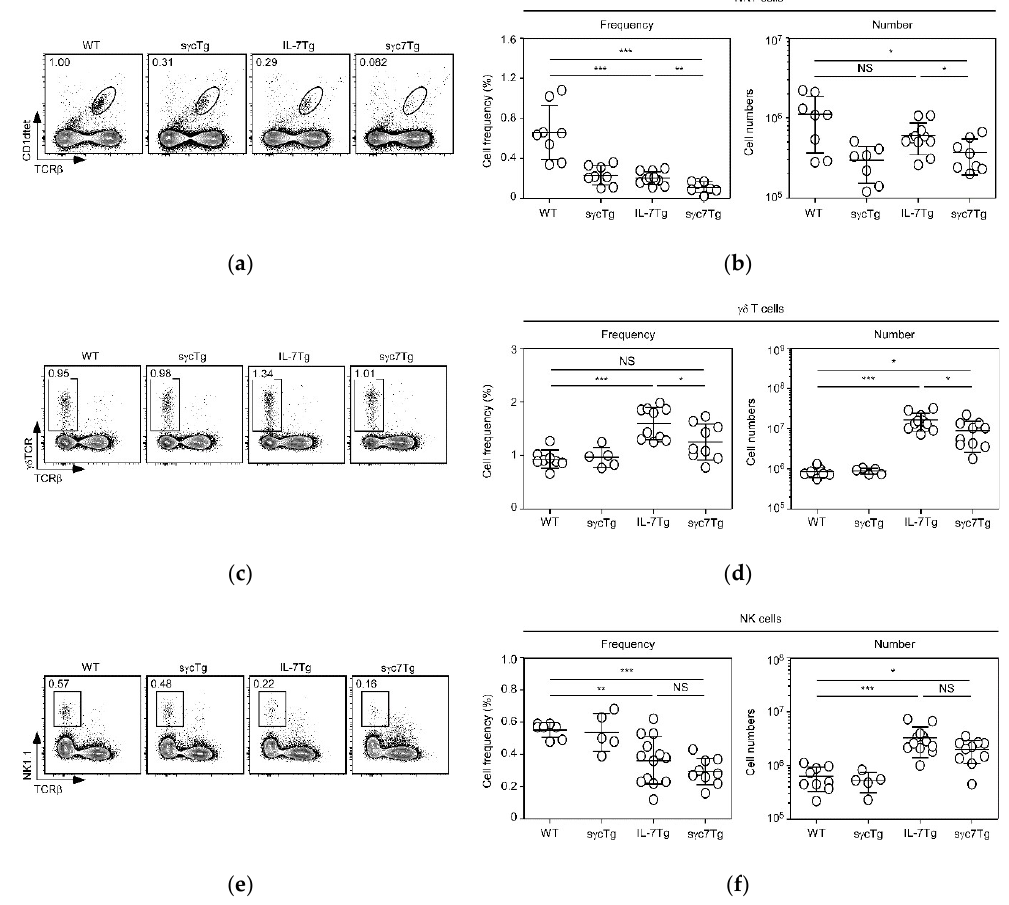
Figure 4. Frequency and total numbers of NKT, γδ T, and NK cells in LN from indicated mice. Contour plots show ( a ) TCR β /CD1dtet, ( c ) TCR β / γδ TCR, and ( e ) TCR β /NK1.1 profiles and percentages of NKT, γδ T, and NK cells, respectively. Summary of ( b ) NKT, ( d ) γδ T, and ( f ) NK cell frequency and numbers. Each symbol represents an indicated individual mouse. Horizontal lines indicate mean and SD. * p < 0.05, ** p < 0.01, *** p < 0.001, and NS mean not